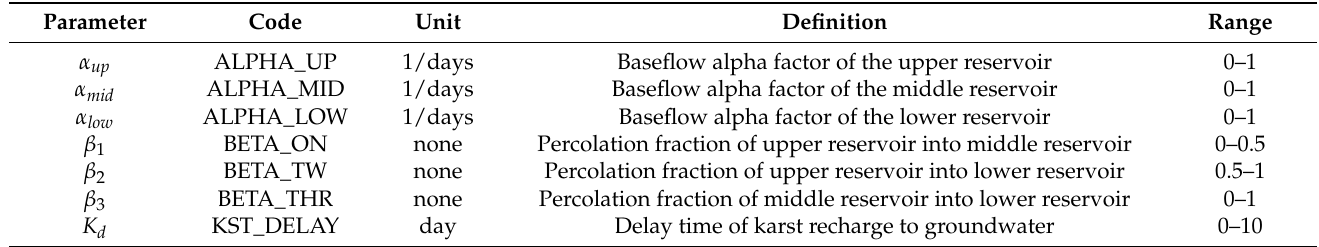
Table 1. Code, definition, and range of the newly added parameters in the modified SWAT groundwater module.